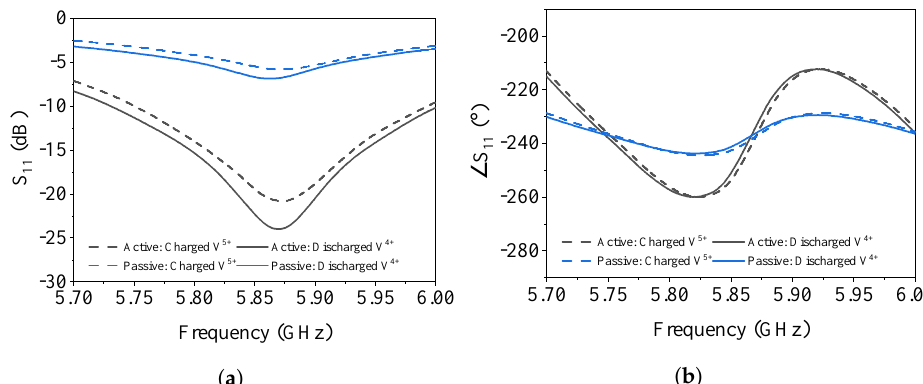
(cid:0) (cid:1) V 5 + and discharged